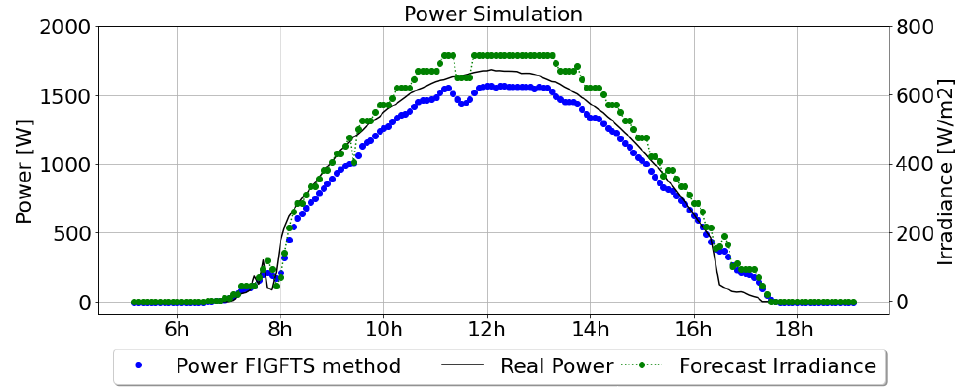
Figure 7. Power simulation for the 5 min horizon with the FIG-FTS method.